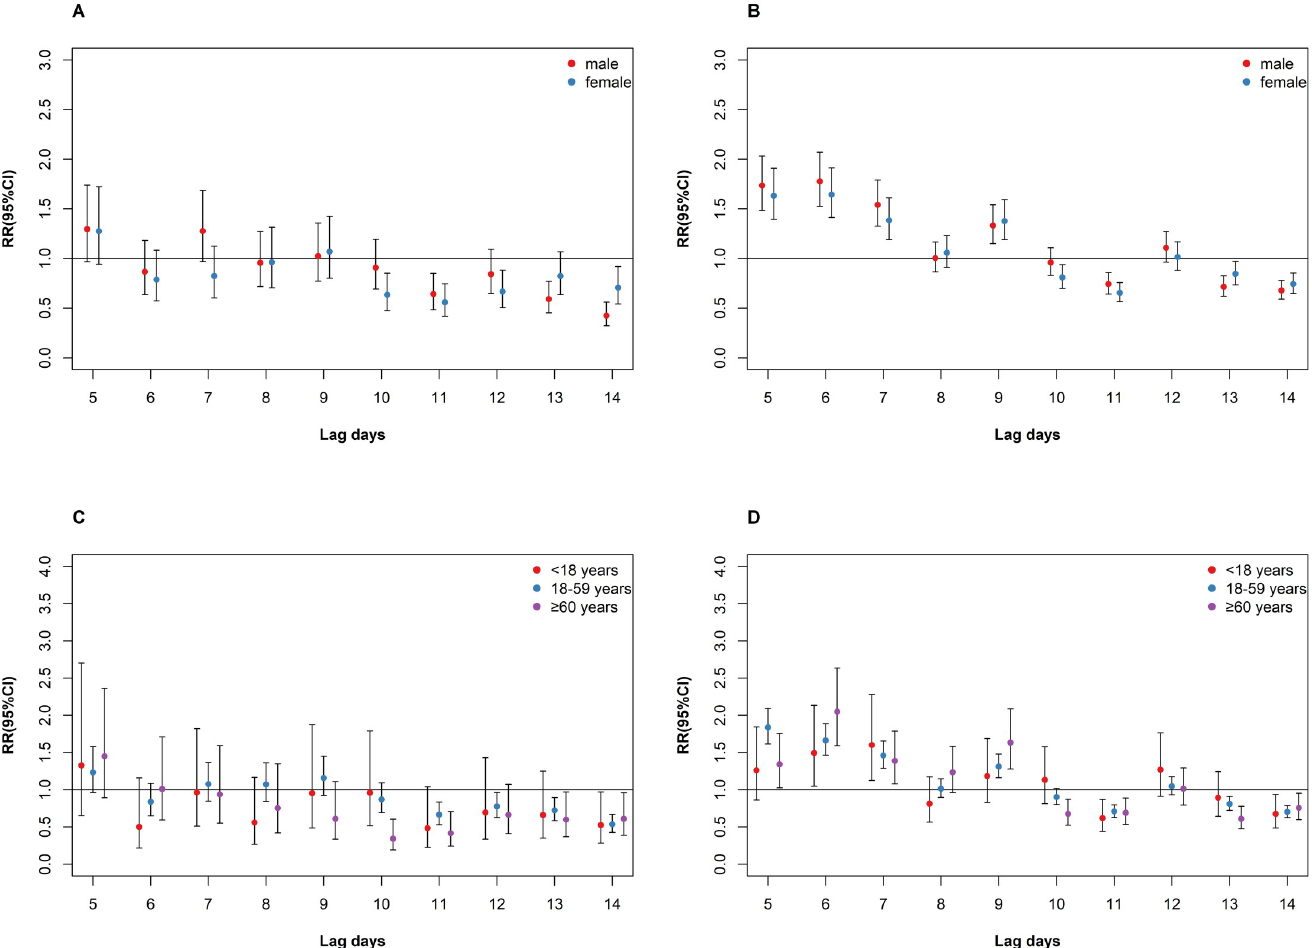
Fig 4. Association between tropical cyclones and risk of DF incidence on lag 5–14 days in the PRD during the study period among population subgroups. A: impact of tropical storms on DF by sex; B: impact of typhoons on DF by sex; C: impact of tropical storms on DF by age-groups; D: impact of typhoons on DF by age-